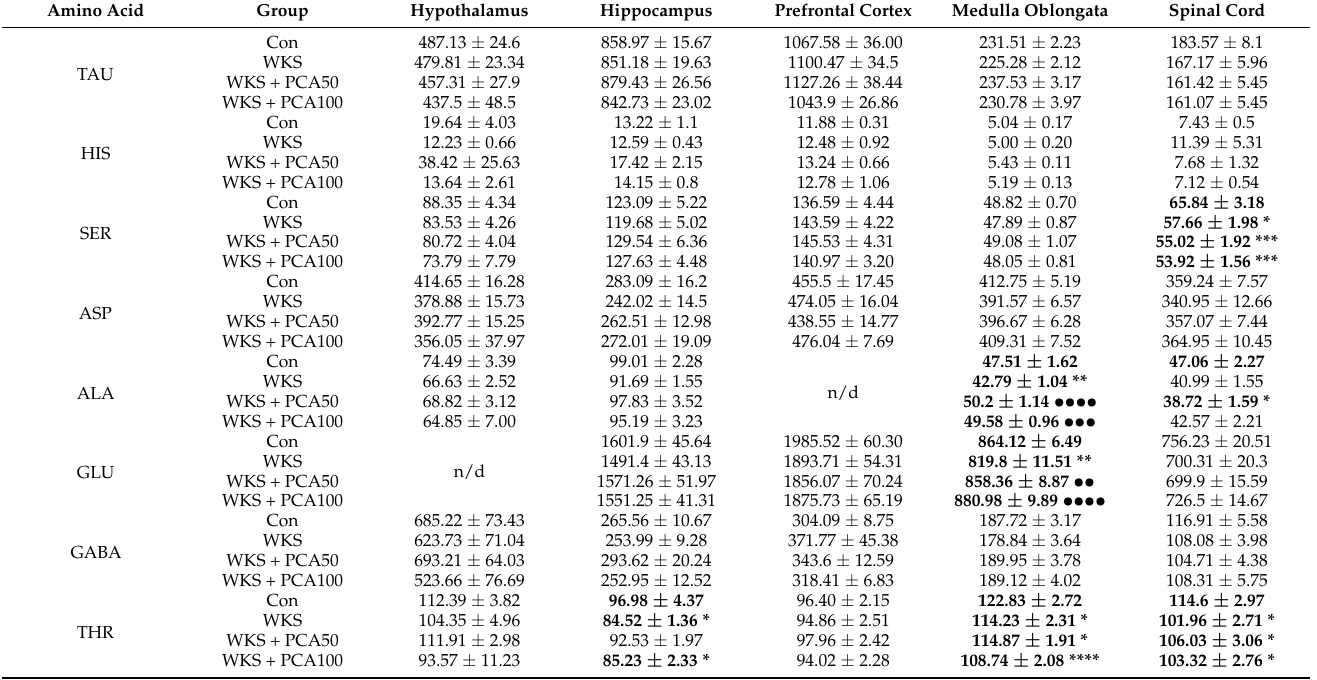
Table 4. Effect of long-term oral administration of PCA at doses of 50 mg/kg and 100 mg/kg on amino acid levels (mean ± SEM) (ng/mg tissue) in PTD model of WKS in